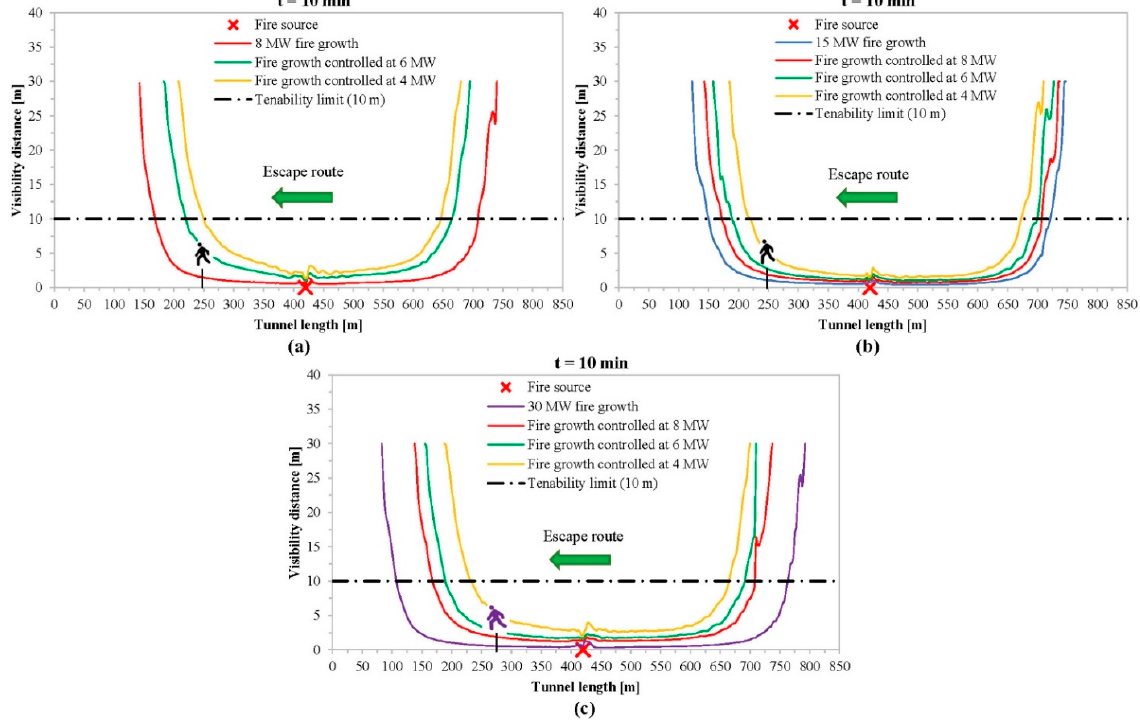
Figure 15. Profiles of longitudinal visibility distance at a height of 2 m along the escape route on the road carriageway after 10 min from the fire’s start when the burning vehicle is at 420 m from portal A and the micronized water system is activated before that the fire growth achieves values of: ( a ) HRR max = 8 MW, ( b ) HRR max = 15 MW, ( c ) HRR max = 30